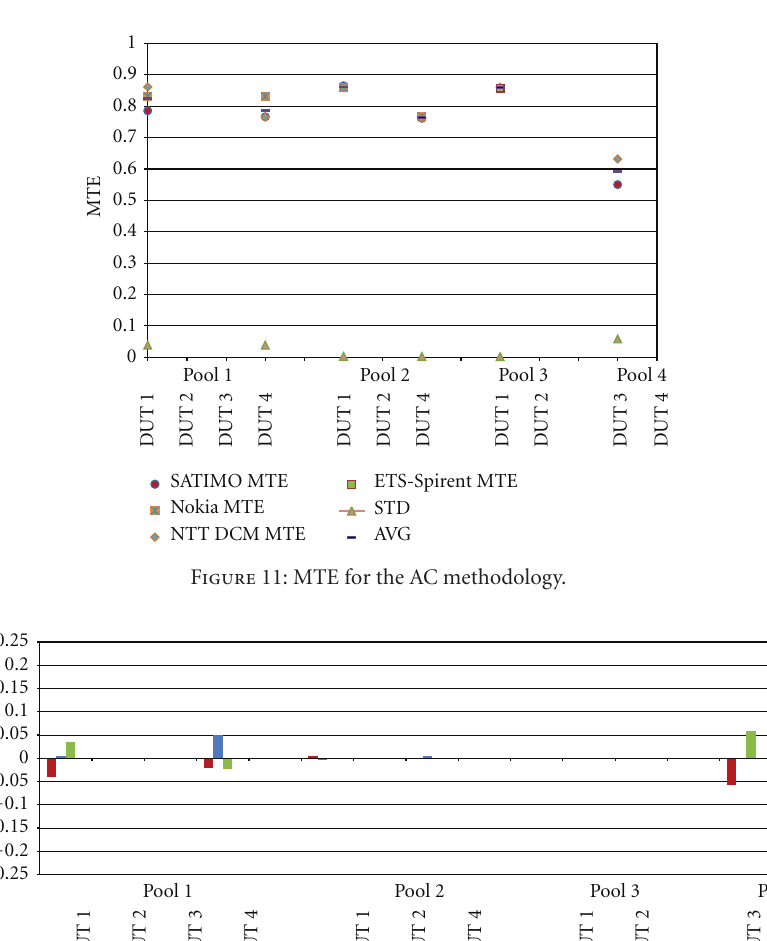
Figure 10: MTE for Pool 4 with the AC methodology.